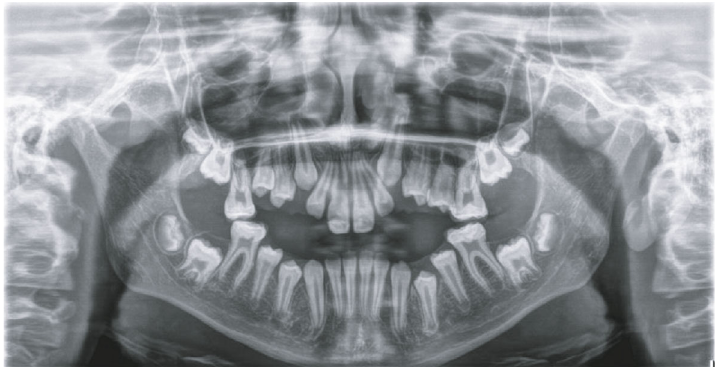
Figure 2: Preoperative panoramic radiographic view.